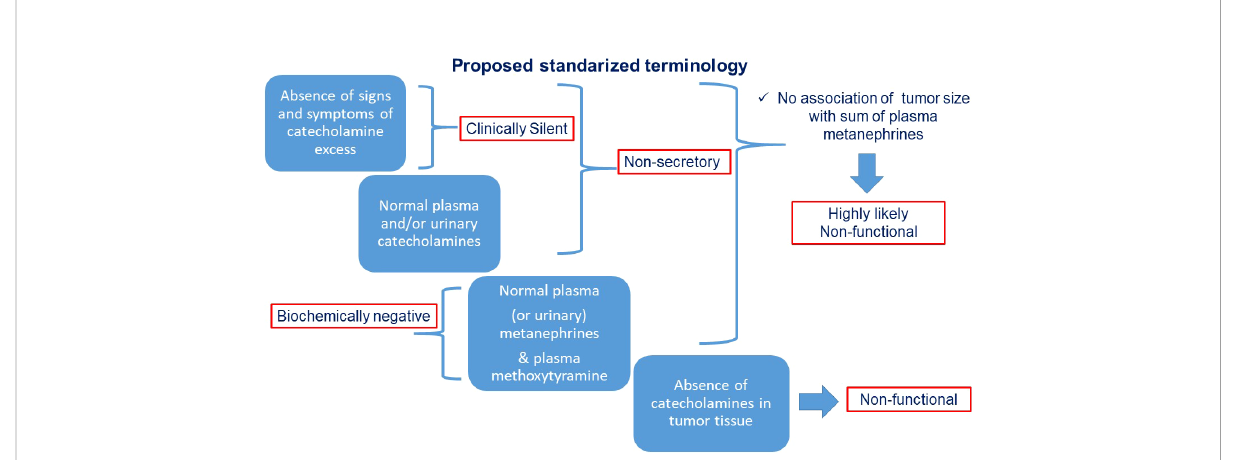
FIGURE 4 Chart fl ow with proposed standardized terminology for various types of “ silent ”